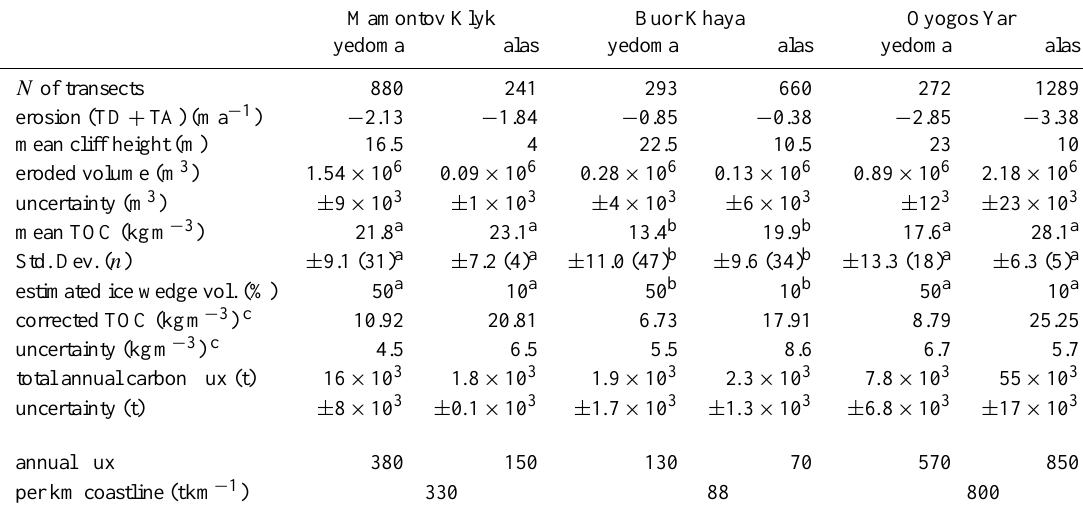
Table 4. Total organic carbon (TOC) flux that result from the erosion observed in the Laptev Sea region. Values are separated by site (Mamontov Klyk, Buor Khaya, Oyogos Yar) and, within each site, by yedoma and thermokarst depression